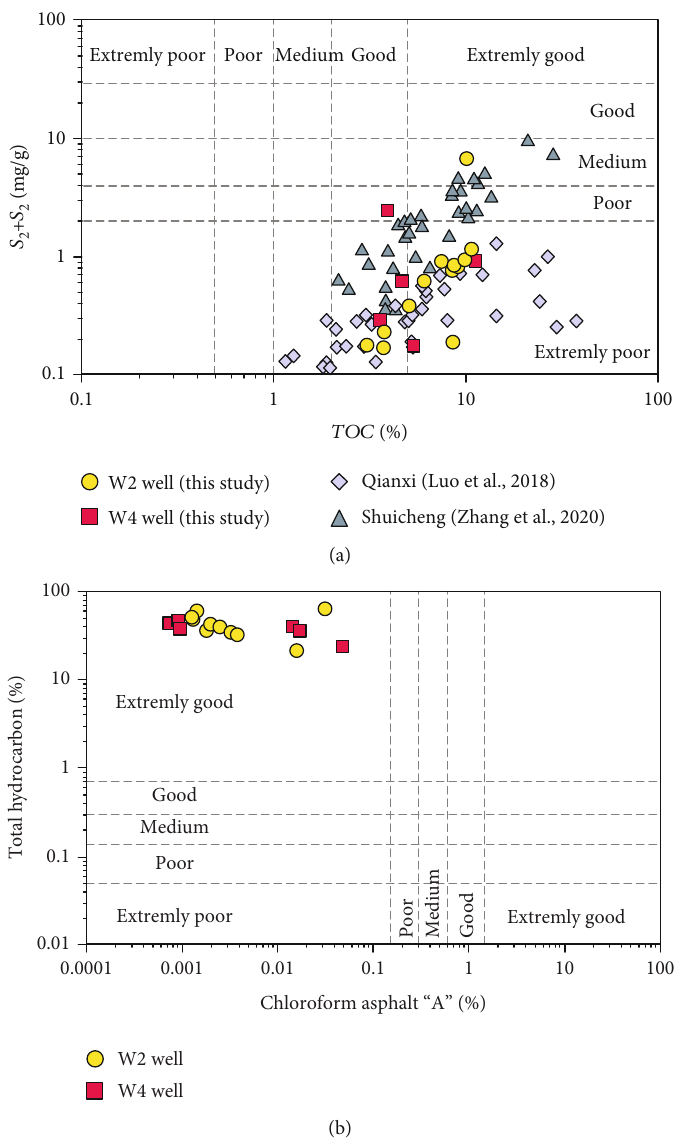
+ S 1 2 and (b) plot of chloroform bitumen